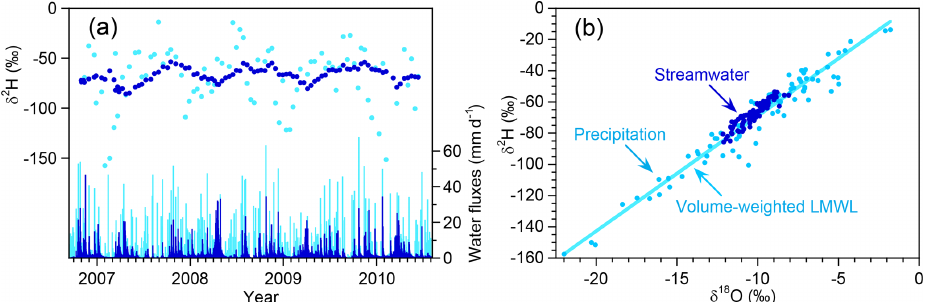
Figure 2. (a) Time series of daily water fluxes and biweekly deuterium values in streamwater (dark blue) and precipitation (light blue) at Watershed 3, Hubbard Brook Experimental Forest (data of Campbell and Green, 2019). (b) Dual-isotope plot showing the local meteoric water line computed by volume-weighted regression ( δ 2 H = 4 . 74 ± 2 . 26 + (7 . 37 ± 0 . 22) δ 18 O). Streamwater lies slightly above the local meteoric water line, on average (lc-excess = 2 . 91 ± 0 . 27‰, mean ± standard error), possibly suggesting slight evaporative fractionation of precipitation within the sample collector or potential fractionation of streamwater by sub-canopy moisture recycling (Green et al.,